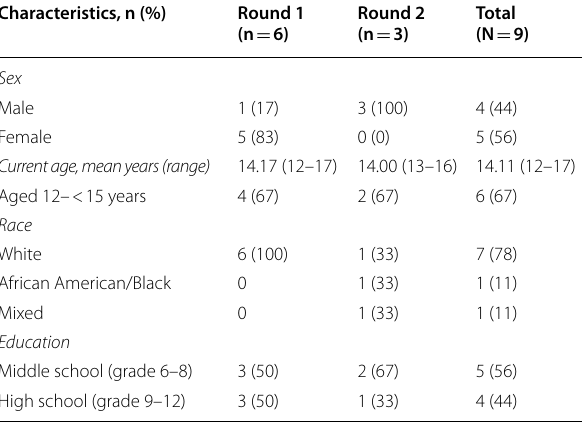
Table 1 Demographic Characteristics Reported at Screening